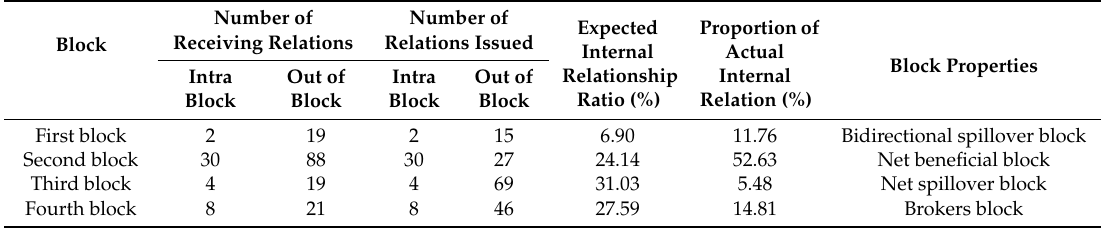
Table 2. Spillover effects of spatial correlation plates of provincial carbon